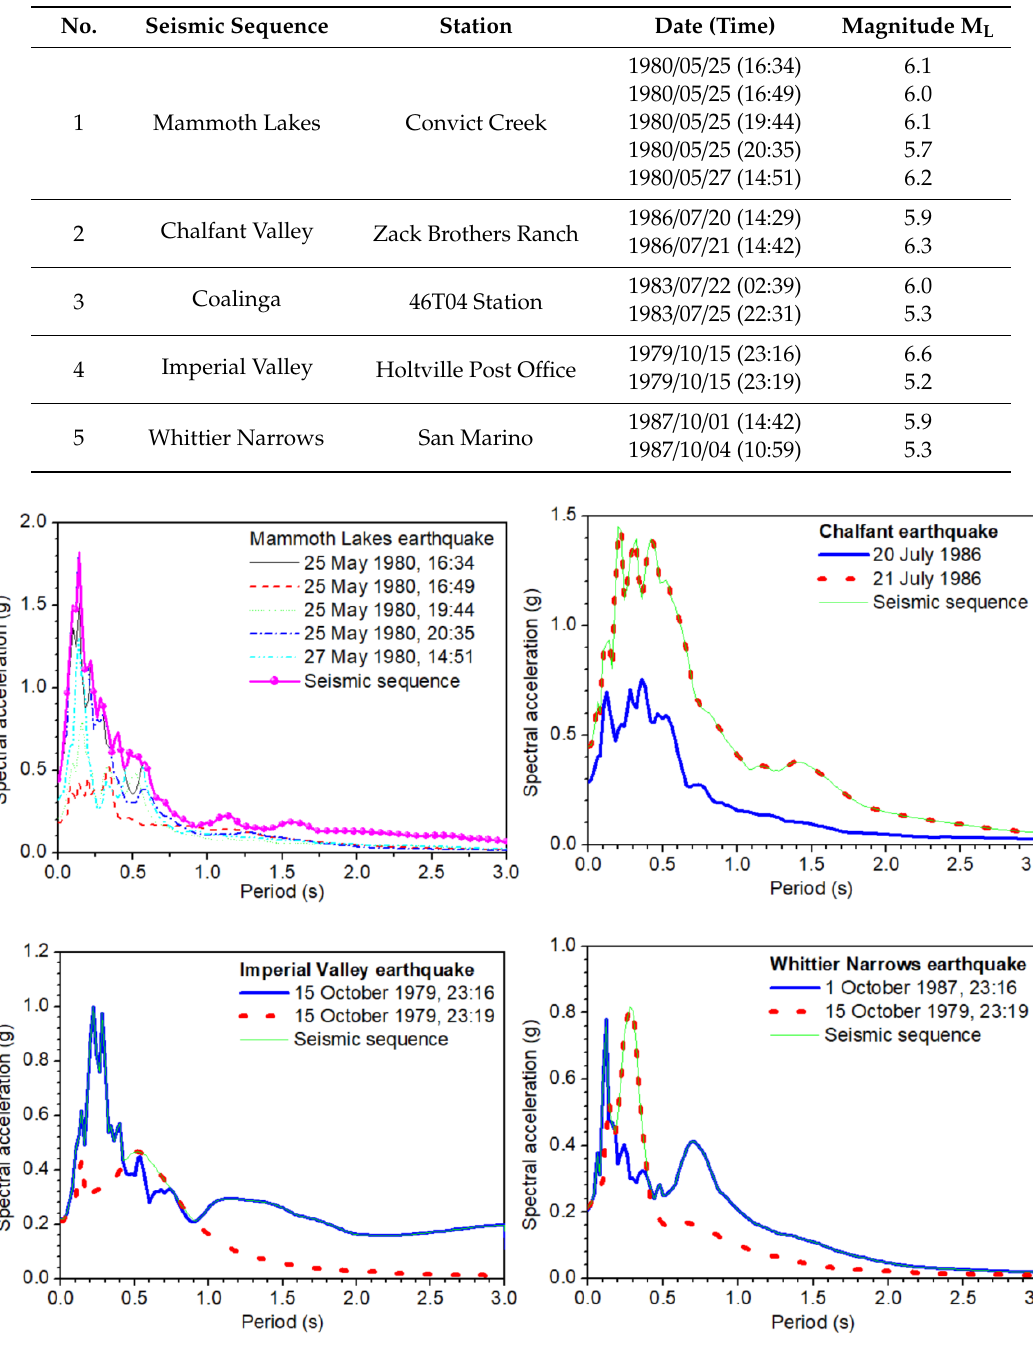
Figure 6. Elastic response spectra of the earthquakes under consideration: single seismic events and seismic sequences.